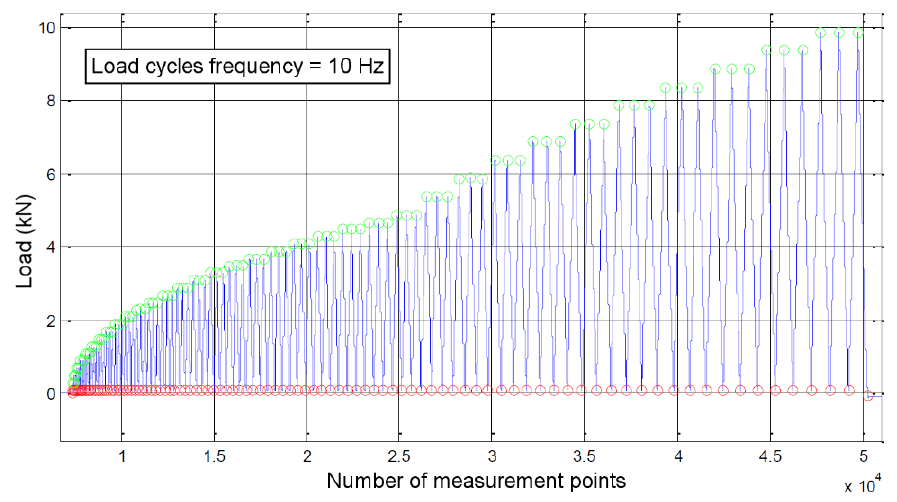
Figure 5. Evolution of the applied load (loading protocol).